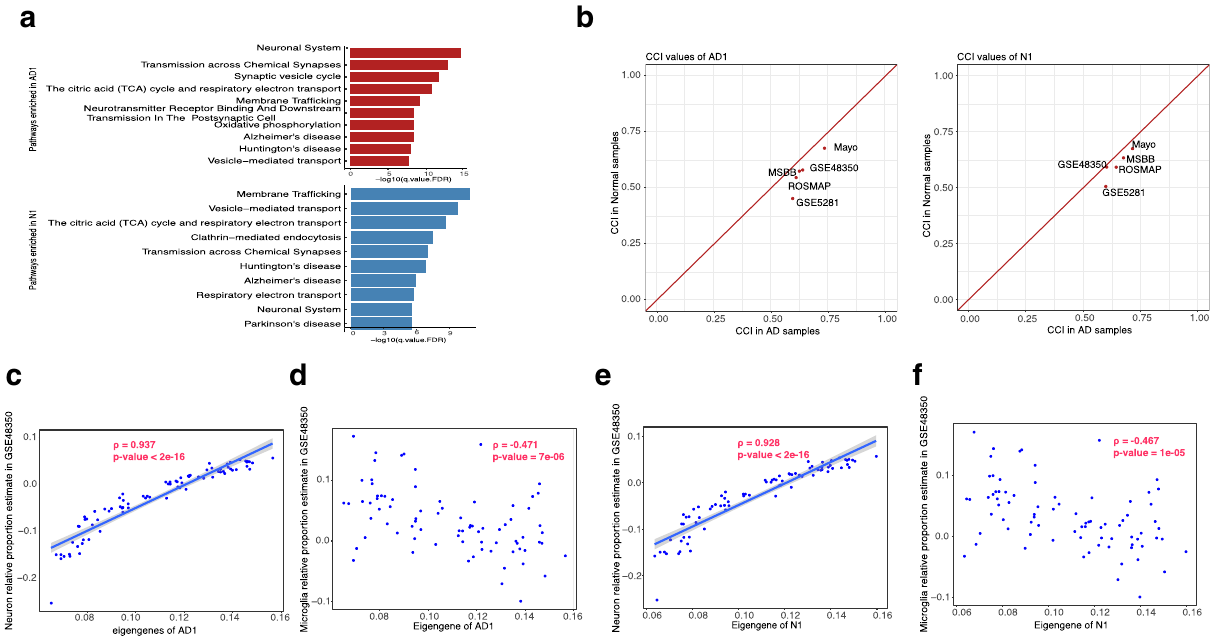
Figure 4. Neuron modules high differential expression and high differential co-expression that may be due to both cell population change and regulatory changes. ( a ) Functional enrichment in the AD1/N1 modules. ( b ) Centered concordance index values of the AD1/N1 modules in AD samples vs. controls in each of the five datasets. ( c ) In the GSE48350 dataset, the Pearson correlation between module AD1 expression (eigengene values) with the estimated relative proportions of neurons. ( d ) The Pearson correlation between AD1 eigengene values and the estimated microglia relative proportions in the GSE48350 dataset. ( e ) The Pearson correlation between N1 eigengene values and the estimated neuron relative proportions in the GSE48350 dataset. ( f ) The Pearson correlation between the N1 eigengene values and the estimated microglia relative proportions in the GSE48350 dataset. This is shown as a poor correlation to compare with panel ( e ).